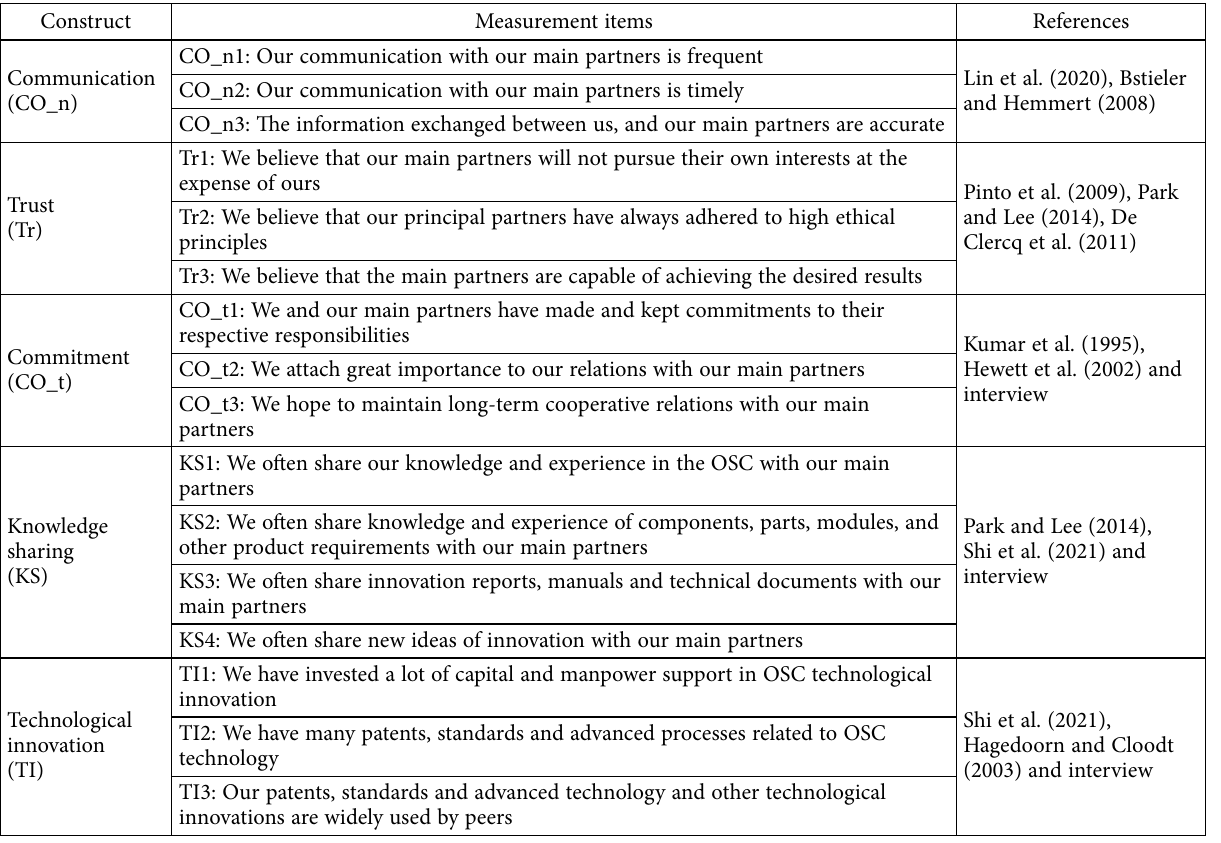
Table 1. Constructs and measurement